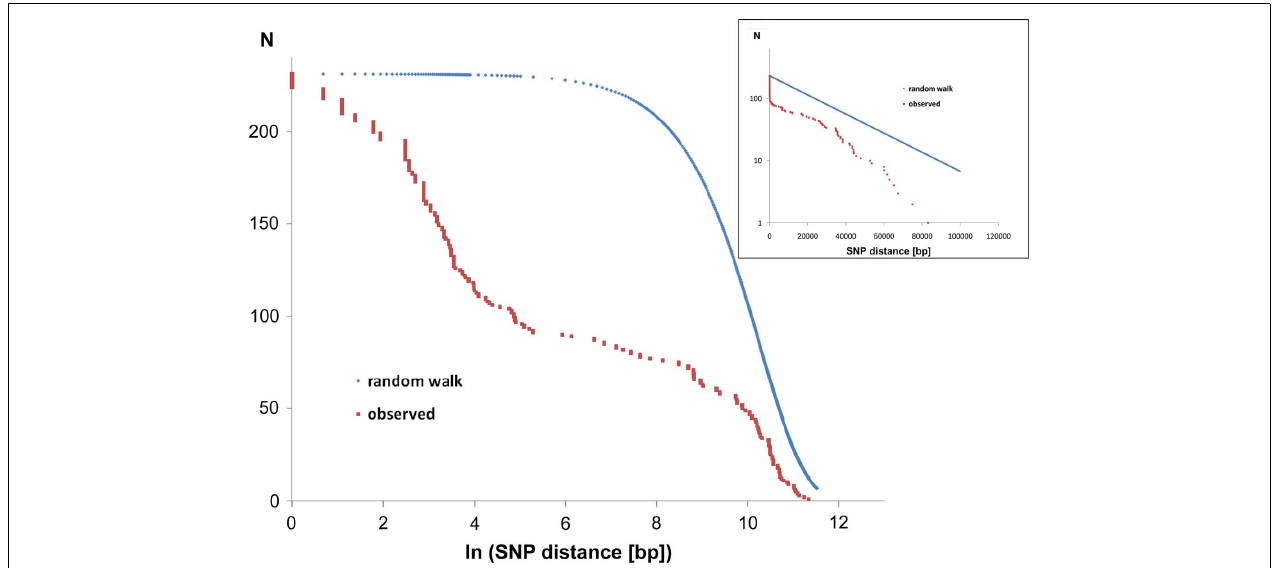
distribution that is compared with a random genomic distribution of the same number of 231 SNPs (blue graphs, one-dimensional random walk statistics). The two semilogarithmic plots visualize the deviation from a random distribution at either a global scale (insert) or with focus on the hotspots of sequence diversity (large